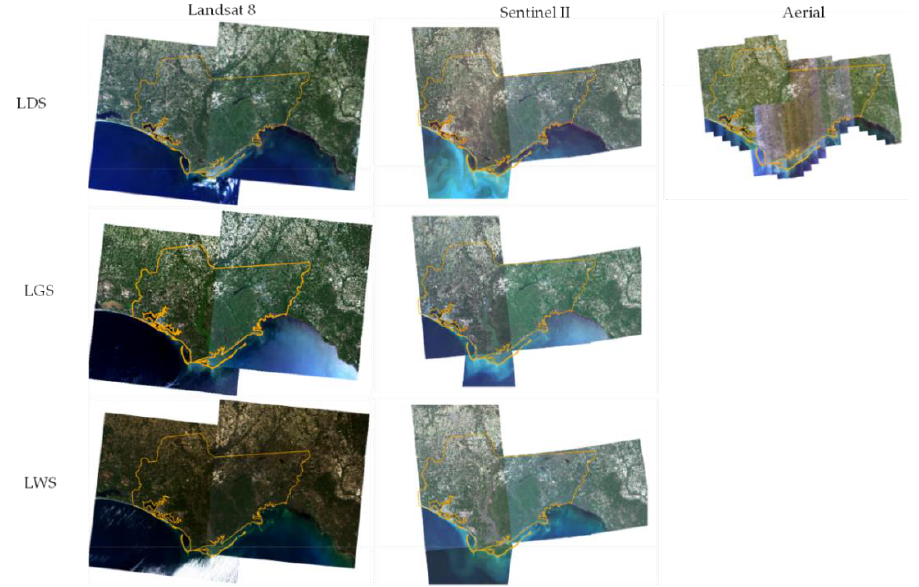
Figure A1. Landsat 8, Sentinel 2, and Quantum Spatial (Aerial) imagery true color mosaics for leaf on fall dormant (LDS), leaf on spring growing (LGS), and leaf off winter (LWS) seasons. The AGSA is outlined in orange. Table A1. Trees species composition for Pine and Other classes based on FIA tree species codes [37]. Class